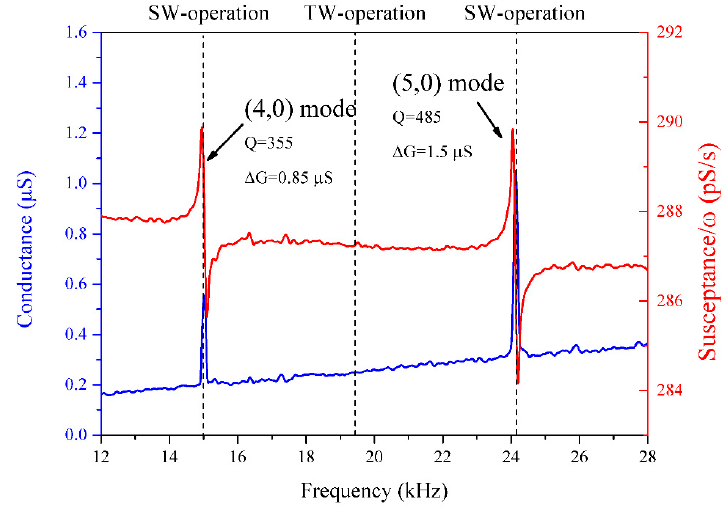
Figure 6. Measured conductance and susceptance of the fabricated device. The first peak corresponds to the (4,0) mode and the second one to the (5,0) mode. Estimated Q-factor and motional conductance are also given. Vertical dashed lines indicated the frequencies for the different operation modes of the motor.